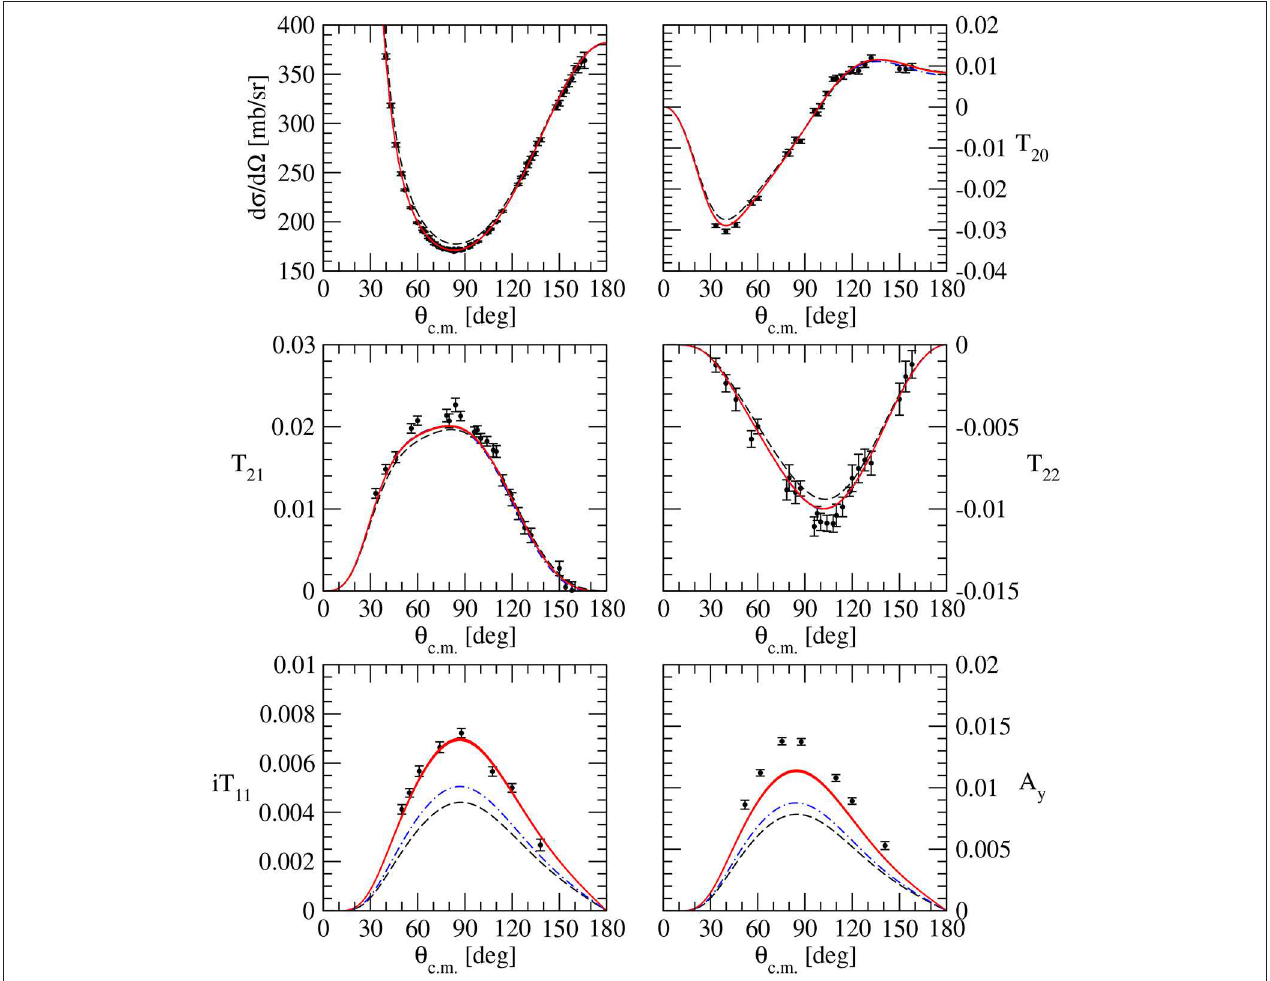
FIGURE 3 | Predictions obtained with the three-nucleon interaction models discussed in the text with 3 = 200 − 500 MeV (red bands) for a set of cross section and polarization p − d observables at 0.666 MeV center-of-mass energy, as compared to the purely two-body AV18 interaction (dashed black lines), to the AV18/UIX two- and three-nucleon interaction (dashed-dotted blue lines), and to the experimental data of reference [90].